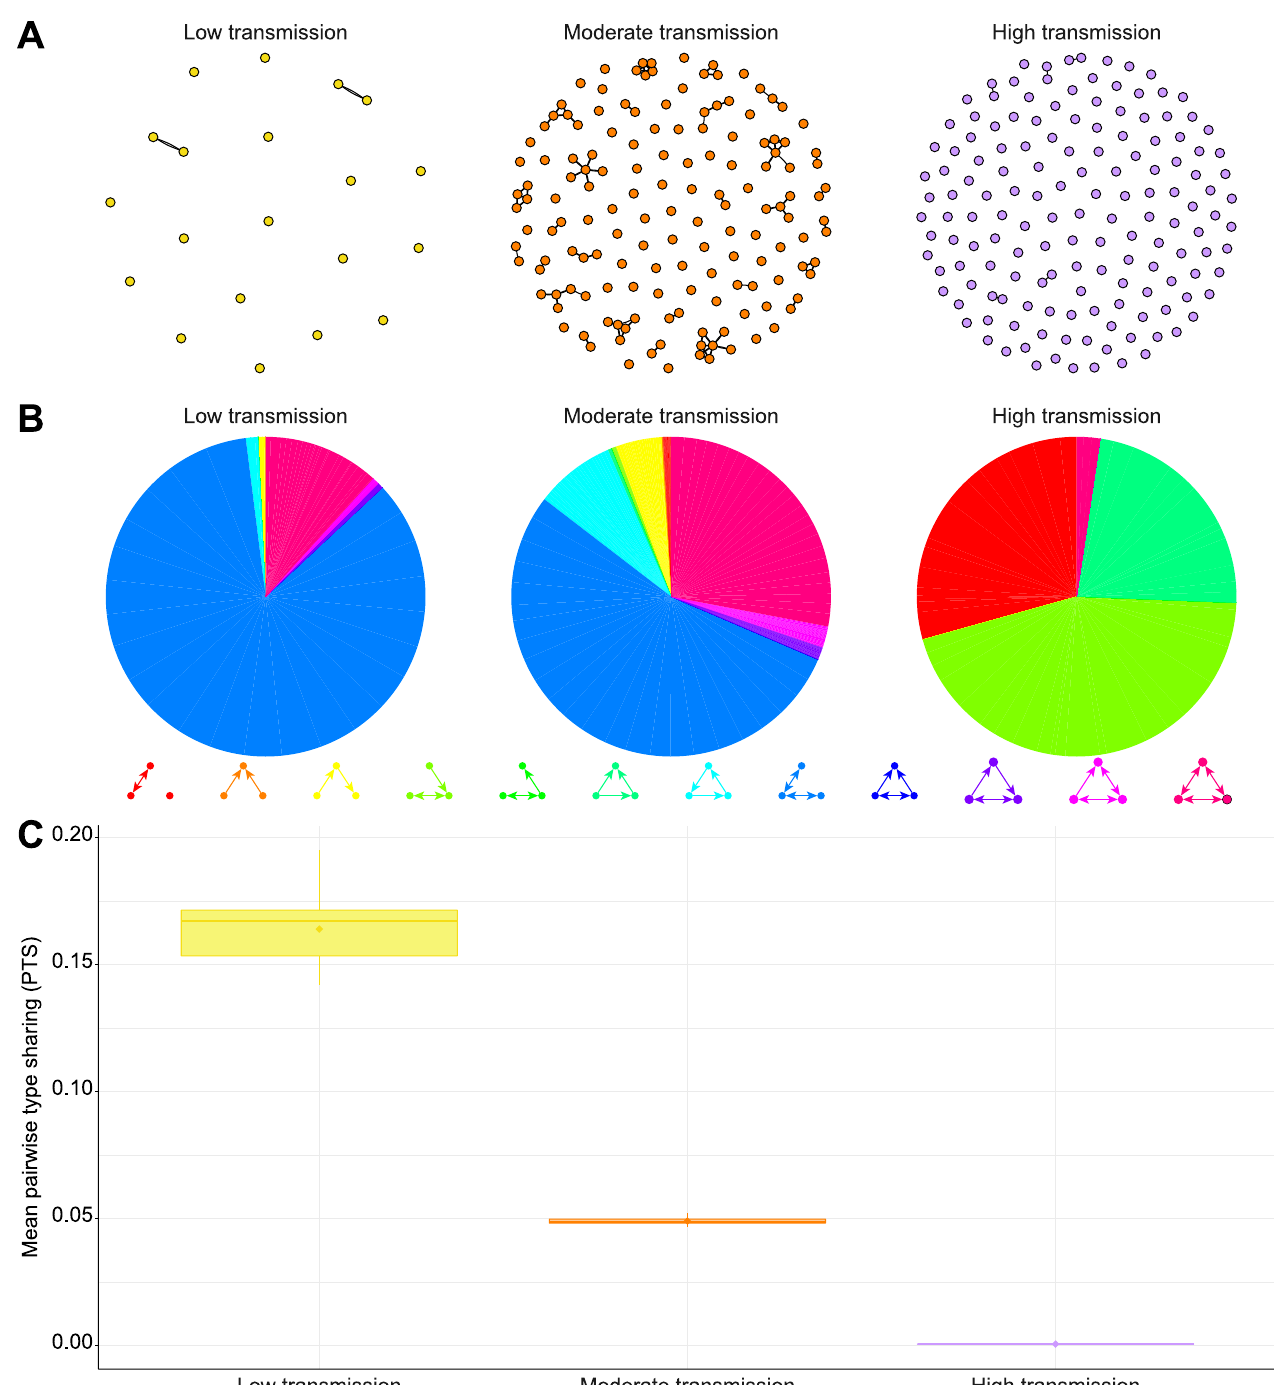
Fig 4. Population structure using network properties. Comparisons of repertoire similarity networks of 150 randomly sampled parasite var repertoires generated from a one-time point under low-, moderate-, and high-transmission settings (i.e., one replicate of runs 1, 25, and 49, respectively; S1 and S2 Tables). Only the top 1% of edges are drawn and used in the analysis. A) Similarity networks where nodes are var repertoires, weighted edges encode the degree of overlap between the var genes contained in these repertoires, and the direction of an edge indicates the asymmetric competition between repertoires. B) Distributions of the average proportion of occurrences of three-node graph motifs across the repertoire similarity networks. C) Distribution of the mean pairwise type sharing (PTS) between var repertoires. For each category, the horizontal central solid line represents the median, the diamond represents the mean, the box represents the interquartile range (IQR) from the 25th to 75th centiles, the whiskers indicate the most extreme data point, which is no more than 1.5 times the interquartile range from the box, and the dots show the outliers, i.e., the points beyond the whiskers.